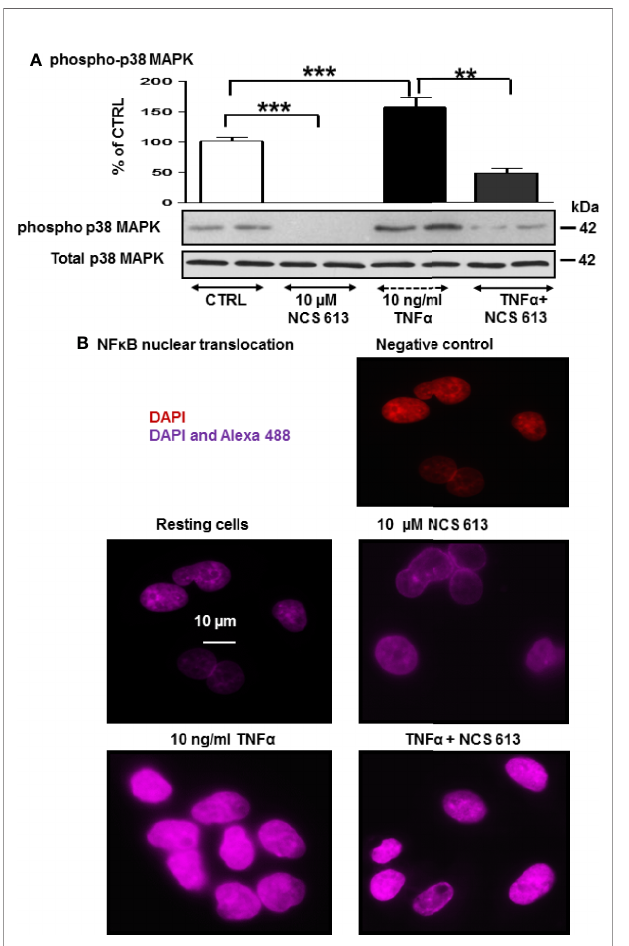
FIGURE 3 | Effect of NCS 613 on p38 MAPK phosphorylation and NF- k B nuclear translocation upon TNF a stimulation. (A) TNF a increases and NCS 613 reduces p38 MAPK phosphorylation in A549 cells; (B) NCS 613 prevents NF- k B translocation into nucleus while TNF a stimulation greatly increases NF- k B p65-subunit translocation into nucleus. Shown are merged images (60x magni fi cation) of DAPI staining and anti-mouse Alexa 654 recognizing primary p65-NF- k B antibody (n=3). Unpaired Student ’ s t -test. Mean ± SEM. ** p < 0.01 and *** p < 0.001.